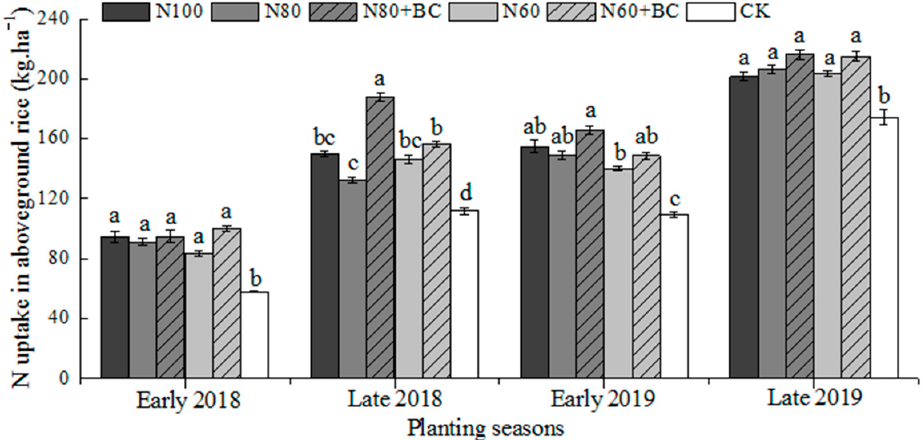
Figure 3. Effects of N fertilizer reduction combined with biochar application on N uptake in aboveground rice. N100, 180 kg N·ha − 1 ; N80, 144 kg N·ha − 1 ; N80+BC, 144 kg N·ha − 1 + biochar; N60, 108 kg N·ha − 1 ; N60+BC, 108 kg N·ha − 1 + biochar; CK, no N and biochar application. Different small